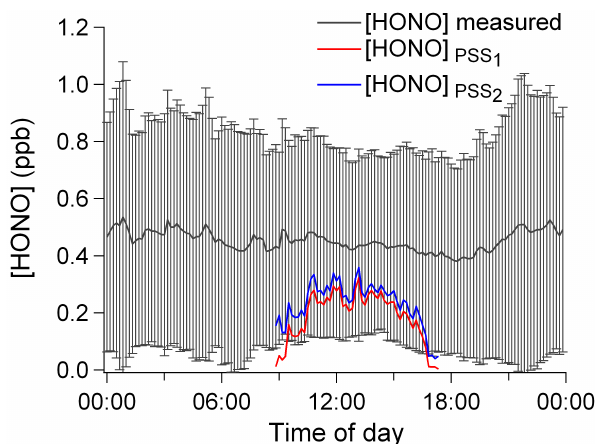
Fig. 8. Mean diurnal profiles of observed [HONO] mixing ratios (black line) and HONO mixing ratios calculated using PSS (red line for Eq. 1 and blue line for Eq. 2) for the MEGAPOLI winter cam- paign. Error bars correspond to standard deviation for day-to-day variability of measurements (local